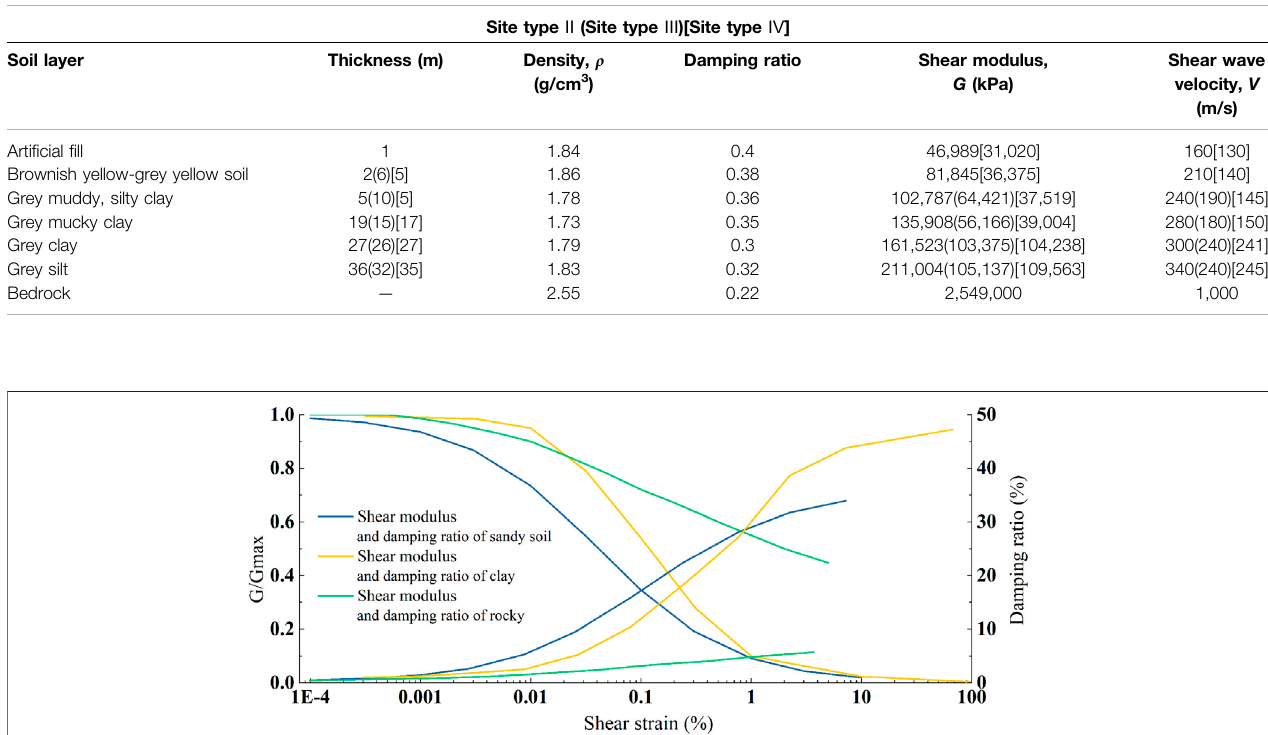
TABLE 1 | The parameters of the soil layer.